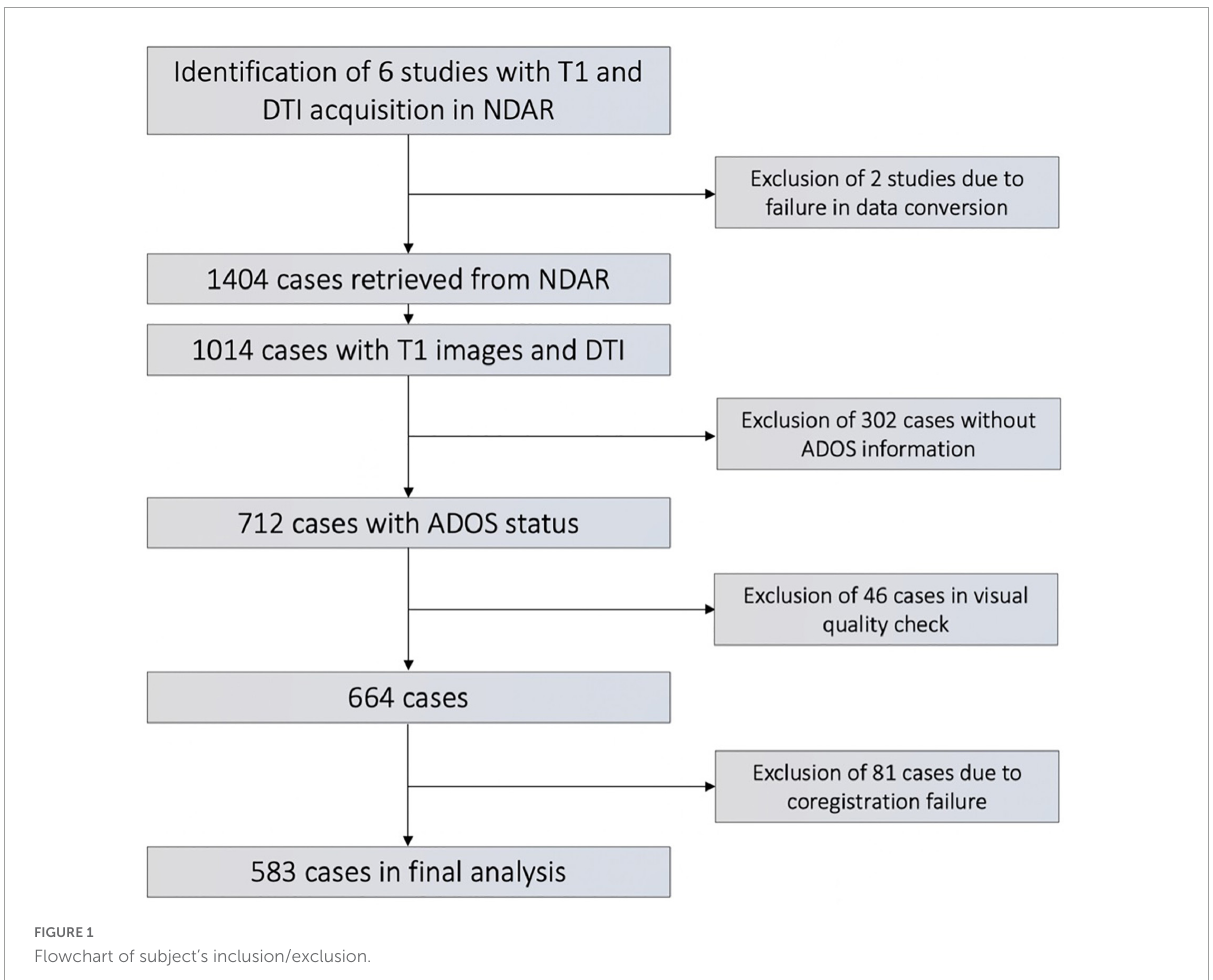
FIGURE1 Flowchart of subject’s